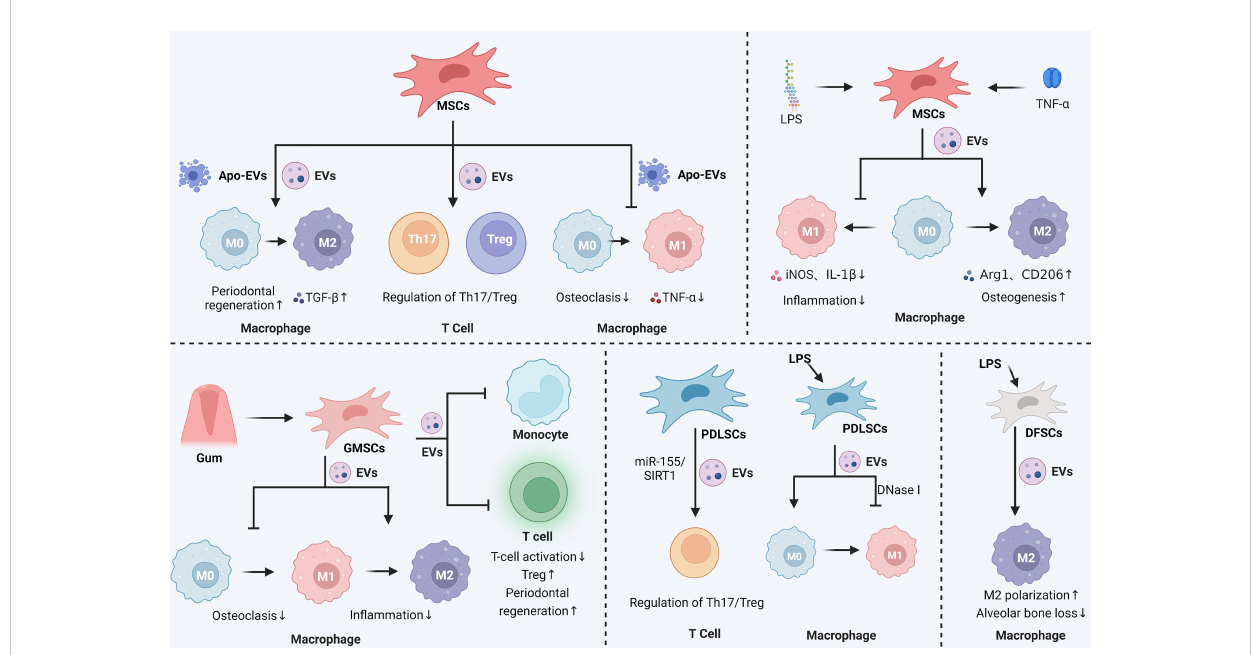
FIGURE 2 Immunomodulatory and anti-in fl ammatory effects of stem cell-derived EVs in periodontitis. In periodontitis, MSCs secreted EVs were able to promote the M2 polarization of macrophages and maintain the balance of Th17 and Treg cell ratio. MSCs secreted apoptotic vesicles were also able to inhibit the M1 polarization of macrophages, reduce the level of in fl ammatory mediators such as TNF- a , and promote the M2 polarization of macrophages. Pretreatment of MSCs with LPS or TNF- a enhanced the effect of MSCs-EVs, mainly by affecting macrophage polarization to control the in fl ammatory response and promote osteogenesis. Gingival mesenchymal stem cells (GMSCs) secrete EVs that affect macrophage polarization and inhibit osteoclastic and in fl ammatory reactions in periodontitis. GMSCs-EVs also inhibit monocyte and T-cell activation and promote periodontal tissue regeneration. Periodontal membrane stem cells (PDLSCs)-derived EVs could regulate the Th17/Treg ratio via the miR-155/SIRT1 axis and inhibit macrophage M1 polarization. LPS-stimulated dental follicular stem cells (DFSCs)-derived EVs also promoted macrophage M2 polarization and reduced alveolar bone loss. The Graph was created with BioRender.com. MSCs: mesenchymal stem cells; EVs, extracellular vesicles; Th, helper T cells; Treg, regulatory T cell; LPS, lipopolysaccharide.